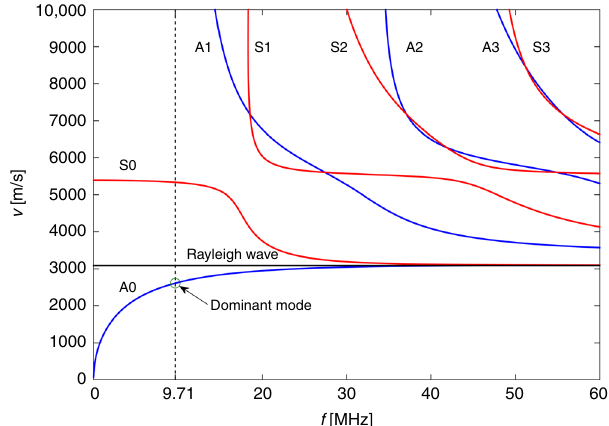
Fig. 3 Dispersion curves for a glass plate. The variation of the phase velocity across a wide range of frequencies. We have access to two different Lamb-type waves (antisymmetric A * and symmetric S *) in a 145 µ m thick glass for the frequency of operation of our device (dashed line). A 0 is the dominant mode due to the excitation source being antisymmetric.